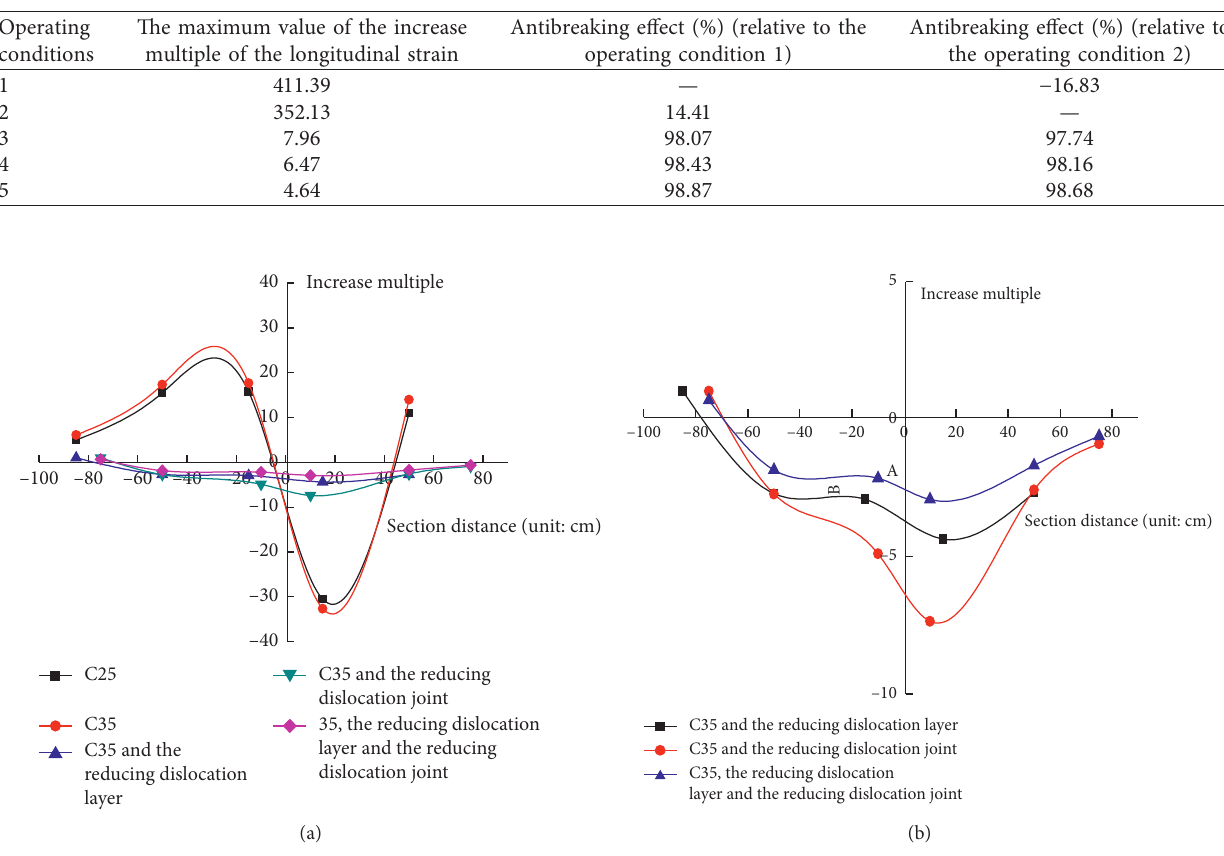
Figure 9: Increase multiple of contact pressure. (a) The operating conditions 1 to 5. (b) The operating conditions 3 to 5.